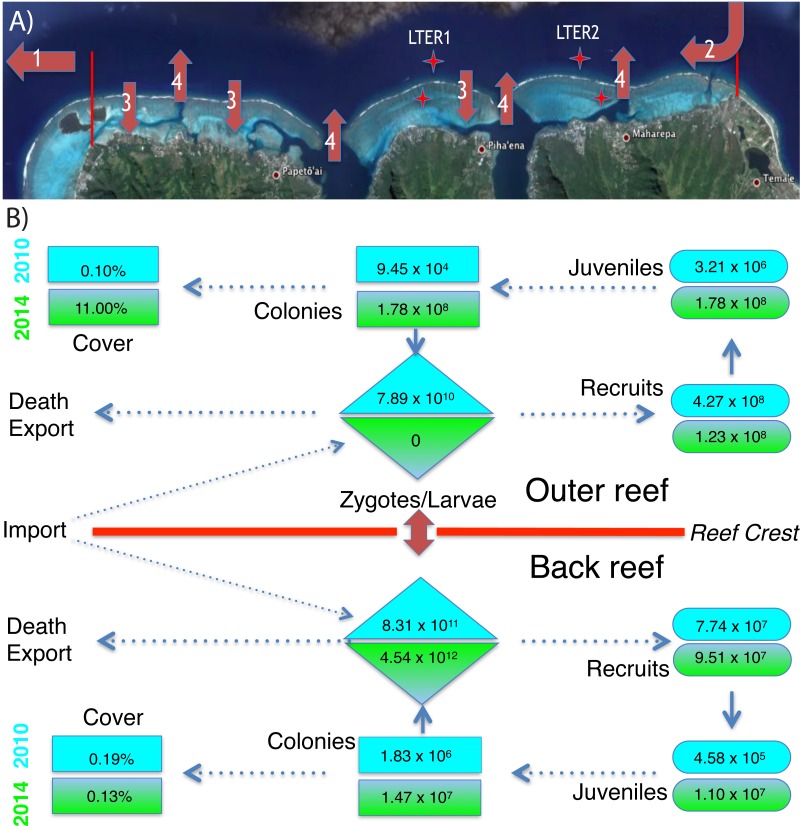
Environmental context and abundance of life stages of Pocillopora spp. on the north shore of Moorea.(A) The north shore of Moorea, is ∼16 km long between the red markers, and the back reef extends from the shore to reef crest (∼750 m) with ∼42% hard bottom (Map data ©2015 Google). The outer reef extends seaward of the reef crest, and ∼200 m from the crest the seawater is ∼17 m deep. Coral larvae can die or be exported from the north shore (arrow 1), imported from nearby islands (arrow 2), and travel repeatedly between the outer and back reef habitats (arrows 3 and 4). Stars mark the location of LTER 1 and 2 on outer reef and back reef. (B) The abundance of Pocillopora spp. in four demographic stages (zygotes/larvae, recruits, juveniles, and all colonies) and their linkage to percentage cover of this taxon in 2010 (blue) and 2014 (green) for the back reef and outer reef. Abundances of each life stage are calculated as described in the text using values shown in Figs. 1 and 2.